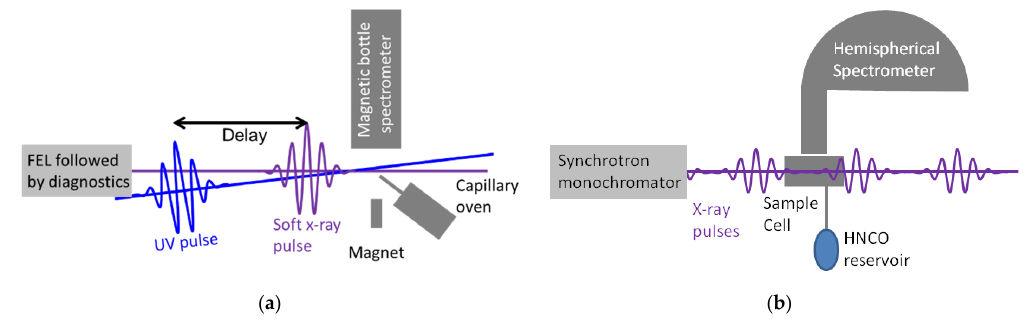
Figure 2. Experimental setups. ( a ) Sketch of the setup at the free electron laser. Molecules are inserted into the interaction region by evaporation in a capillary oven. A first UV pulse ionizes and fragments the molecules. The fragments are then probed by a delayed soft X-ray pulse via core electron ionization. The Auger electrons are collected and analyzed in a magnetic bottle spectrometer. ( b ) Sketch of the setup at the synchrotron beamline. Isocyanic acid is produced close to the beamline and then transported to the spectrometer under cryogenic conditions. The sample is inserted in a differentially pumped cell. Soft X-ray radiation from the monochromator beamline core ionizes the molecules and Auger electrons of HNCO are analyzed via a hemispherical electron